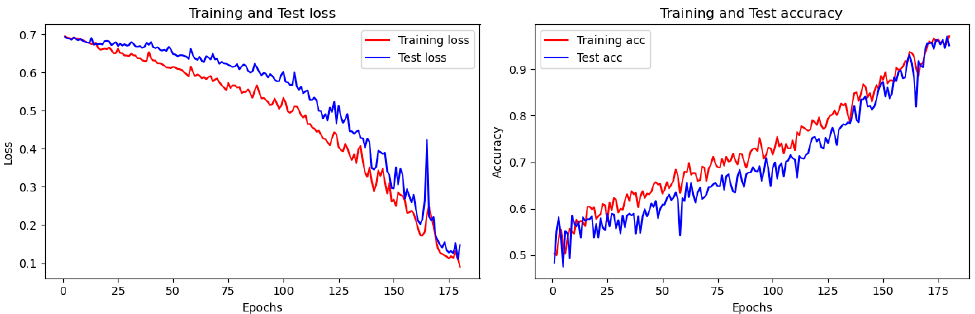
Figure 6. Loss and accuracy of training results.